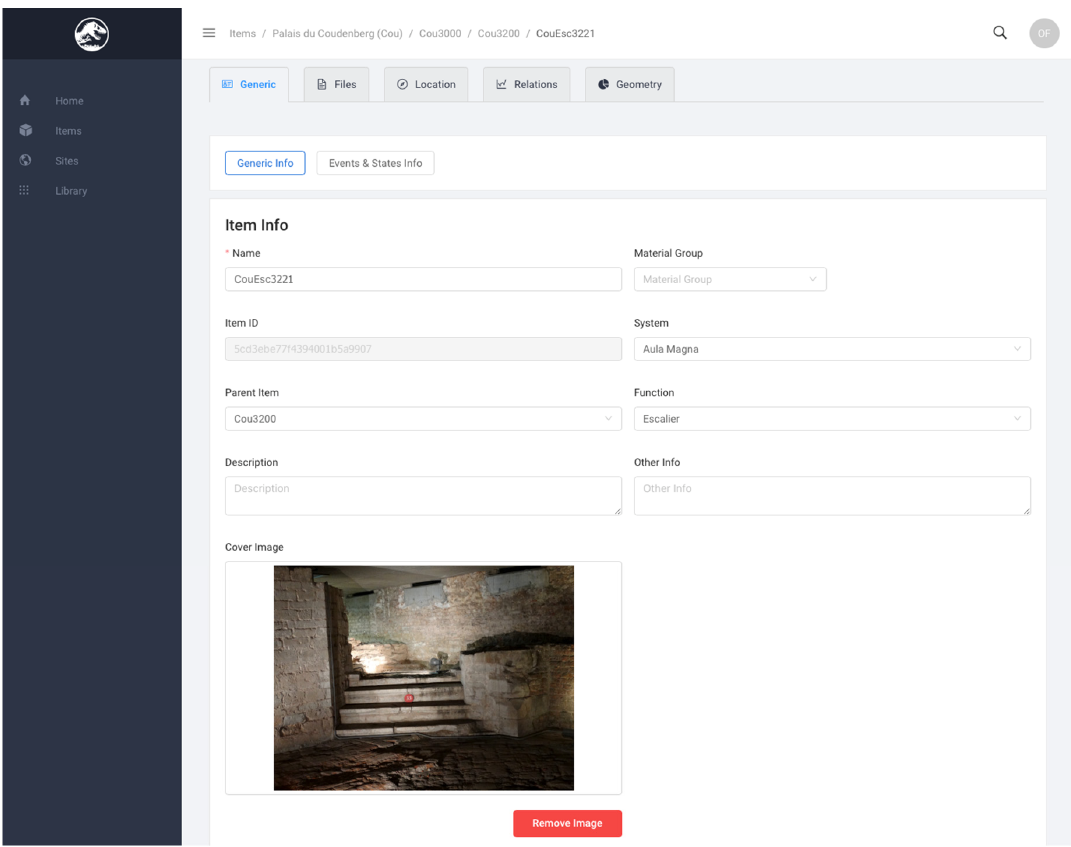
Figure 20. The semantic interface of the HIS.